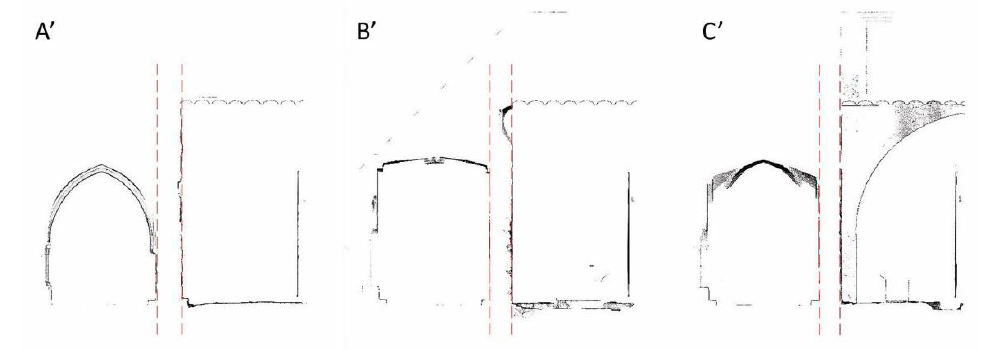
Figure 6. Cross sections of the cloister from the cut planes A’, B’ and C’.